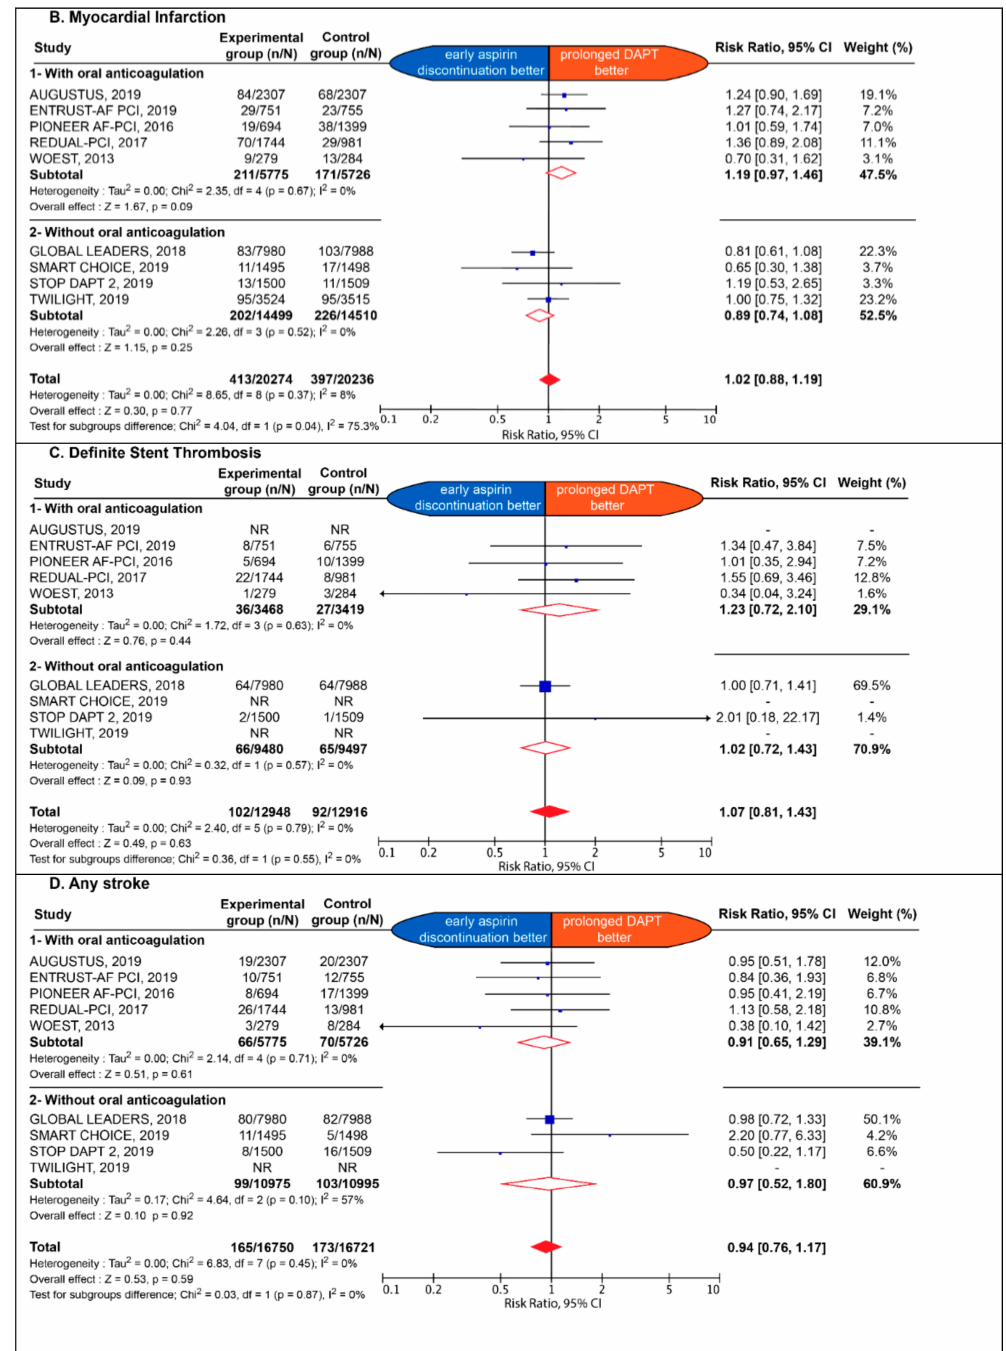
Figure 3. Estimate risk of major adverse cardiac and cerebrovascular events ( A ), myocardial infarction ( B ), definite stent thrombosis ( C ) and any stroke ( D ). CI: confidence interval; DAPT: dual antiplatelet therapy; NR: not